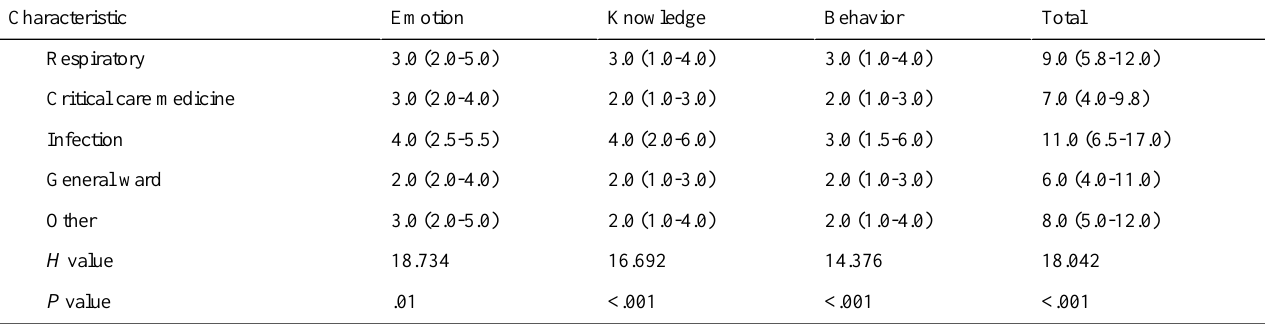
Table 3. Knowledge about prevention and control of COVID-19 among nurses (N=979).